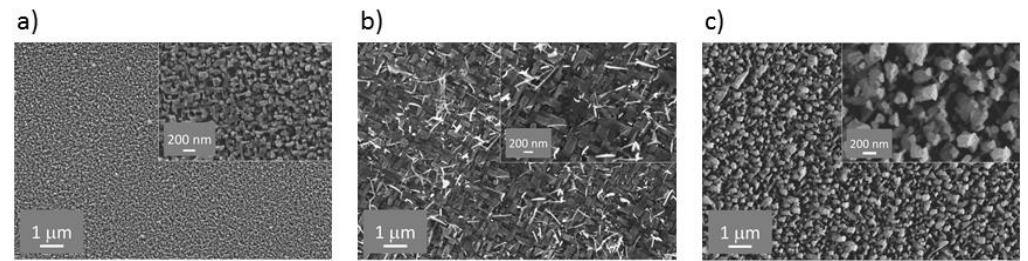
Figure 4. SEM images of samples at position A ( a ), position B ( b ) and position C ( c ) with high-magnification images as insets.